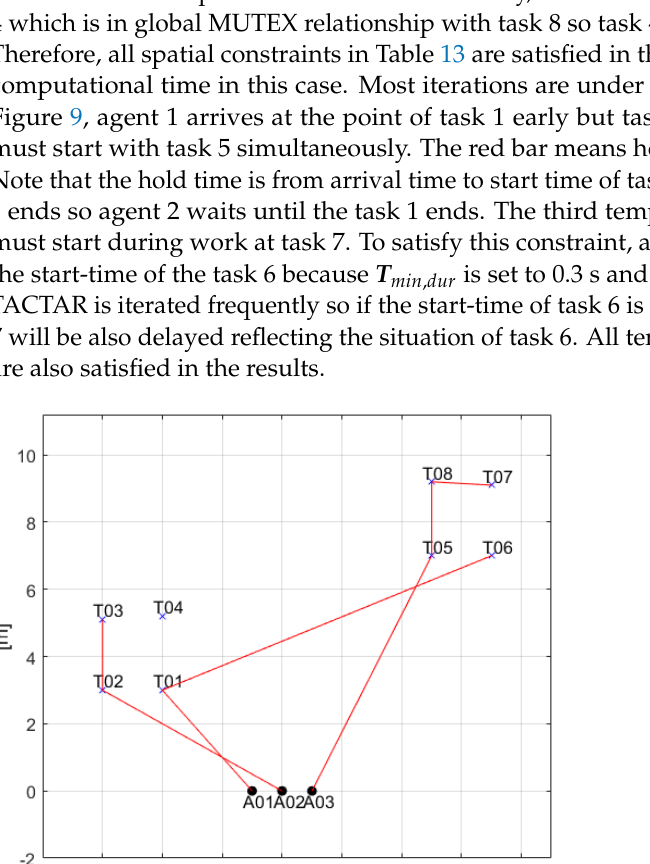
Figure 6. Timetable result of TACTAR for a simple case applying an accumulated distance cost scheme.